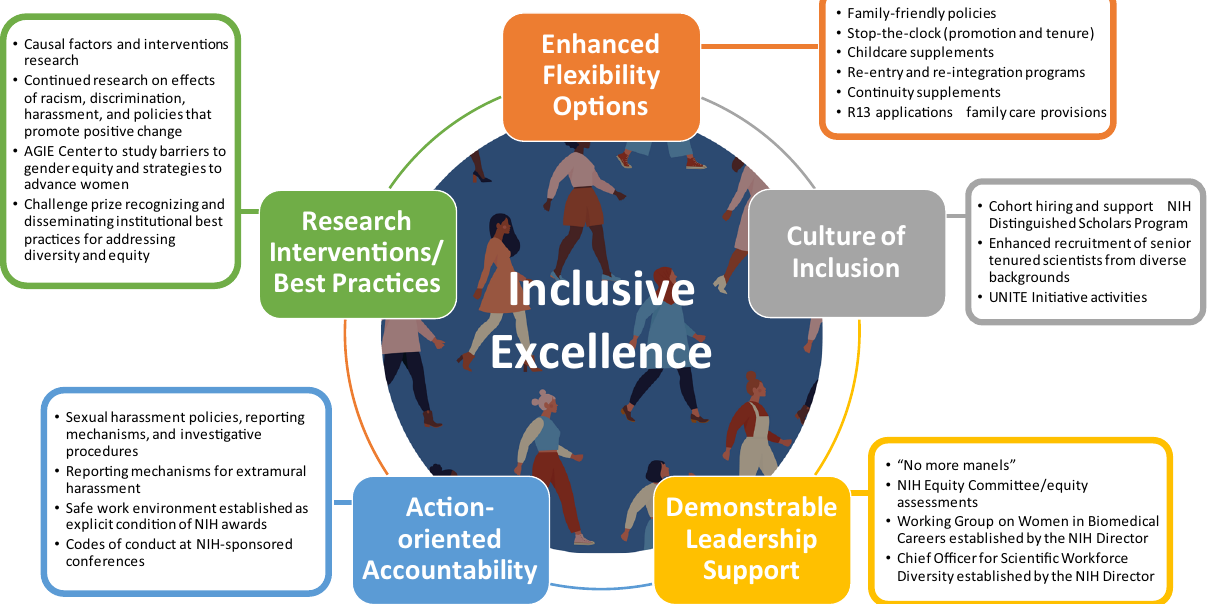
Fig. 1 A multifaceted/coordinated approach to advance inclusive excellence. There are multiple complementary components of inclusive excellence that interact to foster a diverse scienti fi c ecosystem. Support of each component and coordinated action is essential to full inclusion of women in the scienti fi c